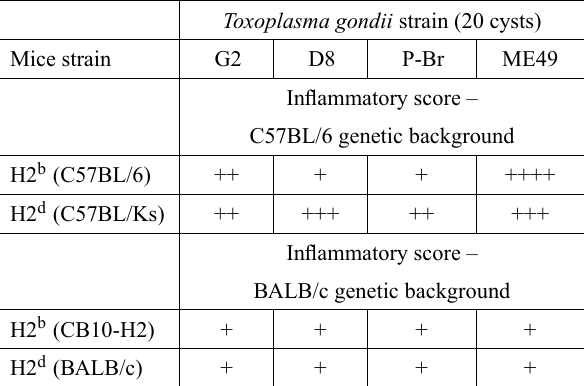
E FFECTOR M ECHANISMS IN C ONTROL OF C YST N UMBERS AND H OST R ESISTANCE TO I NFECTION WITH T YPE I/III S TRAINS OF T.